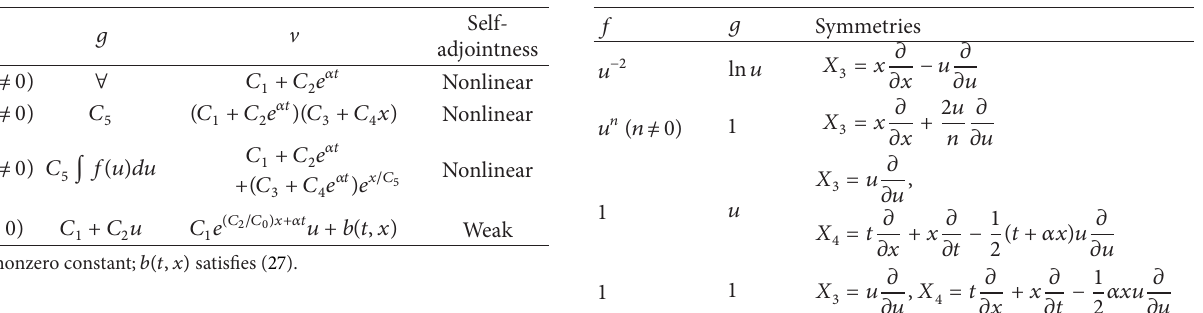
Table 1: Nonlinear self-adjointness of (3). Table 2: Symmetries of (3) for some special choices of 𝑓 and 𝑔